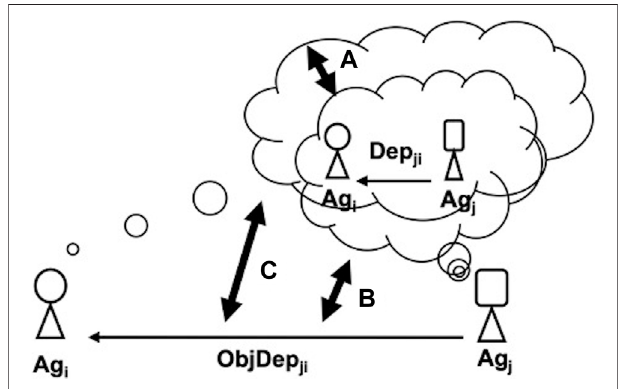
FIGURE 6 | Dependence of Ag i from Ag j on the task τ . (A) comparison on how it is believed by Ag i and how Ag j believes it is believed by Ag i ; (B) comparison on how it is believed by Ag i and the objective reality; (C) comparisononhowAg j believesitisbelievedbyAg i andobjectivereality.